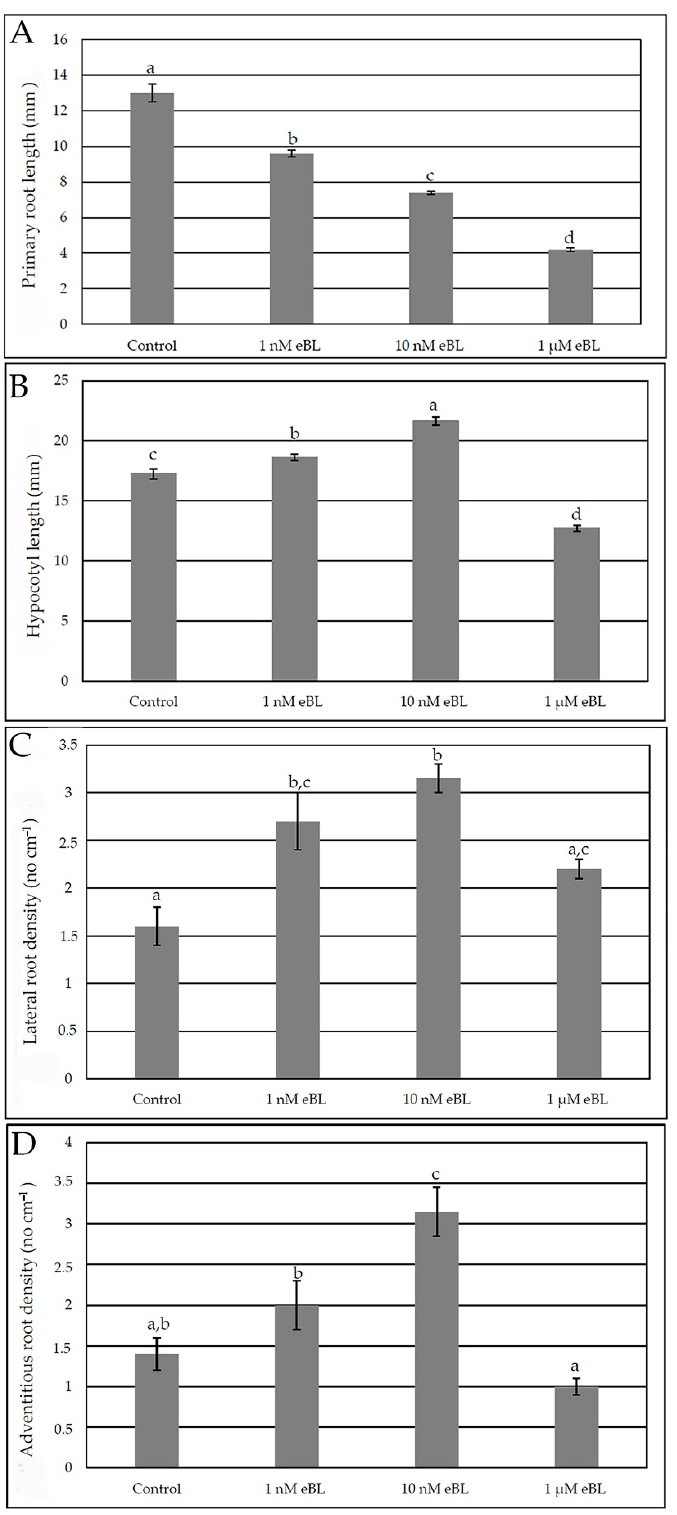
Figure 1. Primary root mean length (±SE) ( A ), hypocotyl mean length (±SE) ( B ), mean density of lateral roots (±SE) ( C ) and mean density of adventitious roots (±SE) ( D ) of Col seedlings cultured for 9 days under continuous darkness followed by 7 days under 16 h light/8 h darkness photoperiod on ½ MS medium (see Section 4) (Control treatment), or on the same medium plus either 1 nM eBL, 10 nM eBL, or 1 μ M eBL. Different letters show significant differences for at least p < 0.05. n = 30. Data from the first replicate.